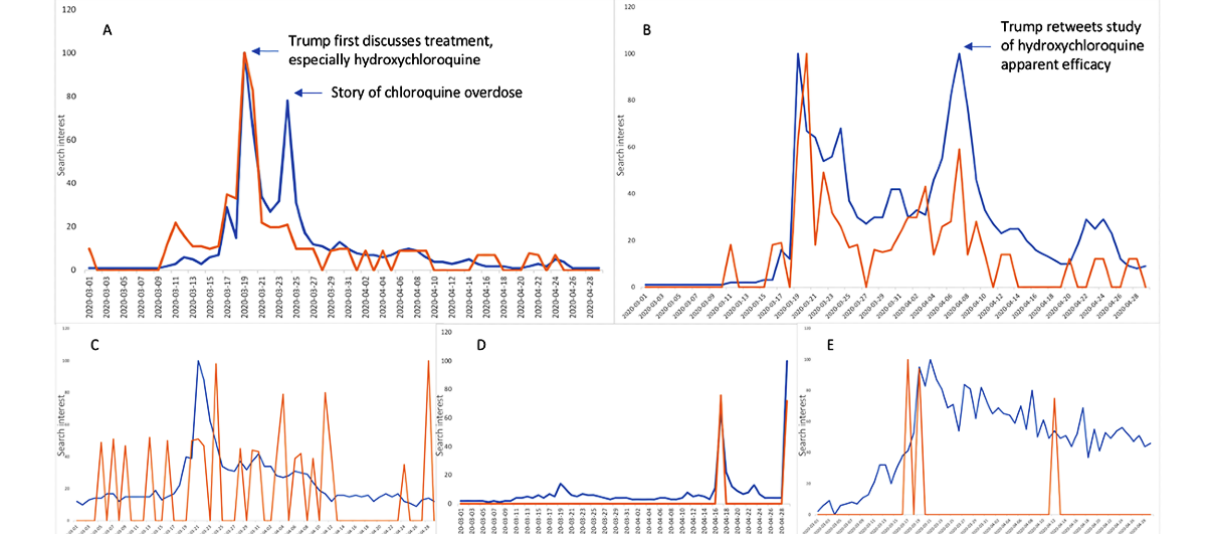
Figure 2. Google searches (blue line) for and purchases (orange line) of keywords. (A) Results for the term "chloroquine." (B) Results for the